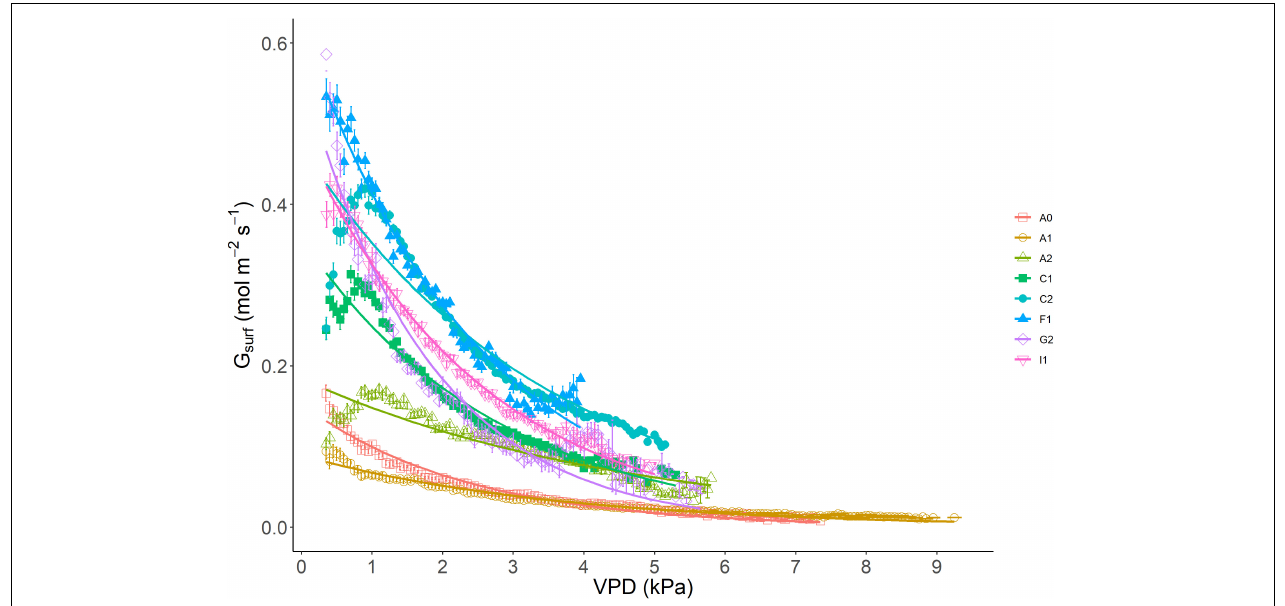
FIGURE 2 | Response of G surf to VPD in different sites (absolute values). Data are binned using 0.1 kPa bin size. SE per each interval of 0.1 kPa of VPD is shown on site-related